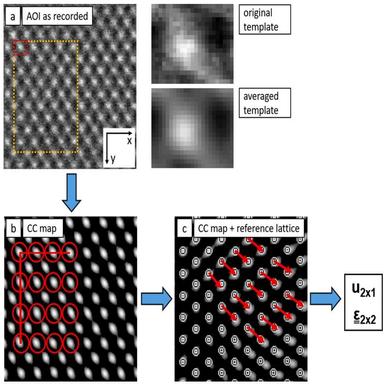
Basis principle and steps of TeMA. (a) Template definition and spatial averaging. (b) Cross correlation and reference lattice definition. (c) Determination of deviations between measured lattice and superimposed reference lattice. The displacements in (c) are indicated by the red arrows, which are exaggerated for visualization purposes.